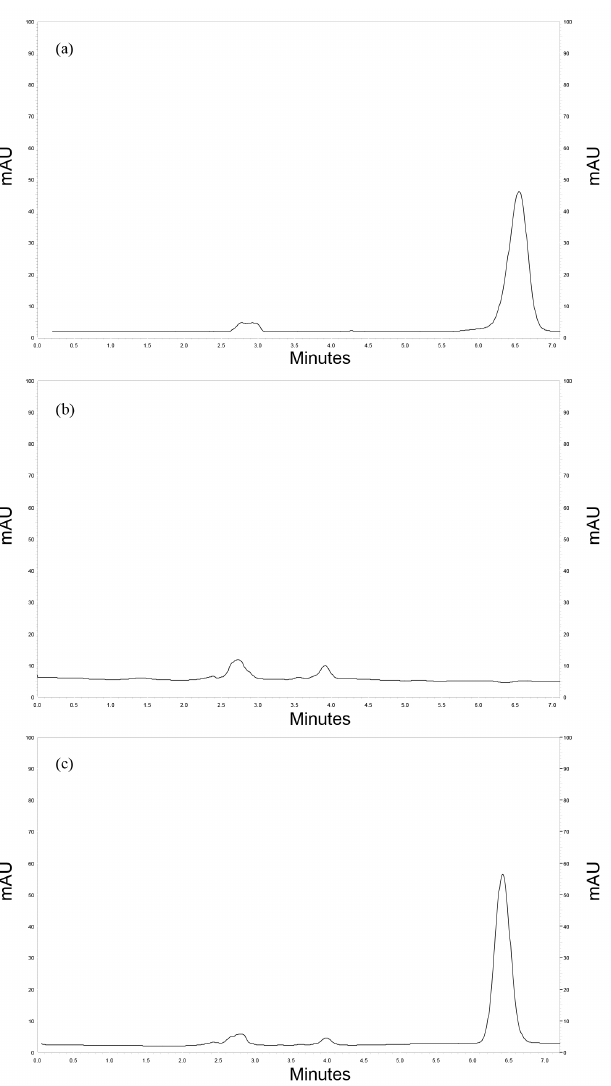
FIGURE 2 - Chromatograms of standard solution (a), blank nanocapsules (b), beclomethasone dipropionate-loaded nanocapsules